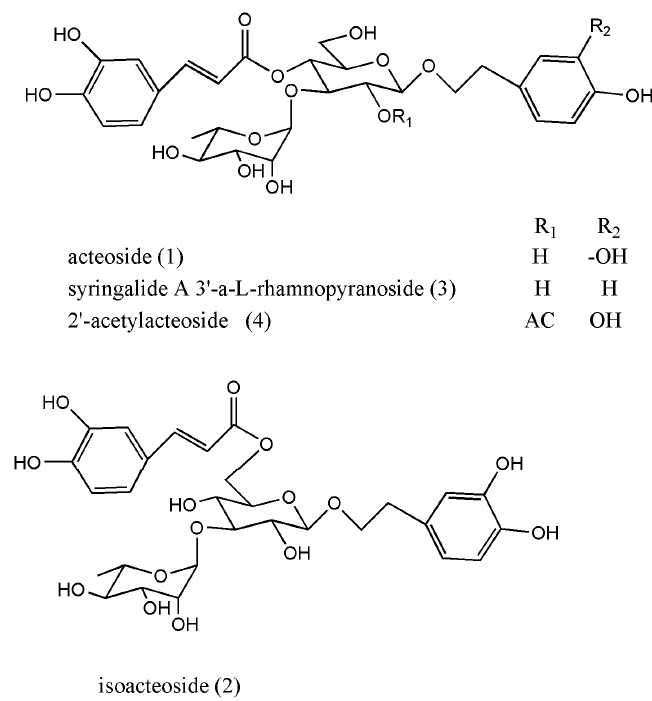
Figure 1. The structures of four isolated